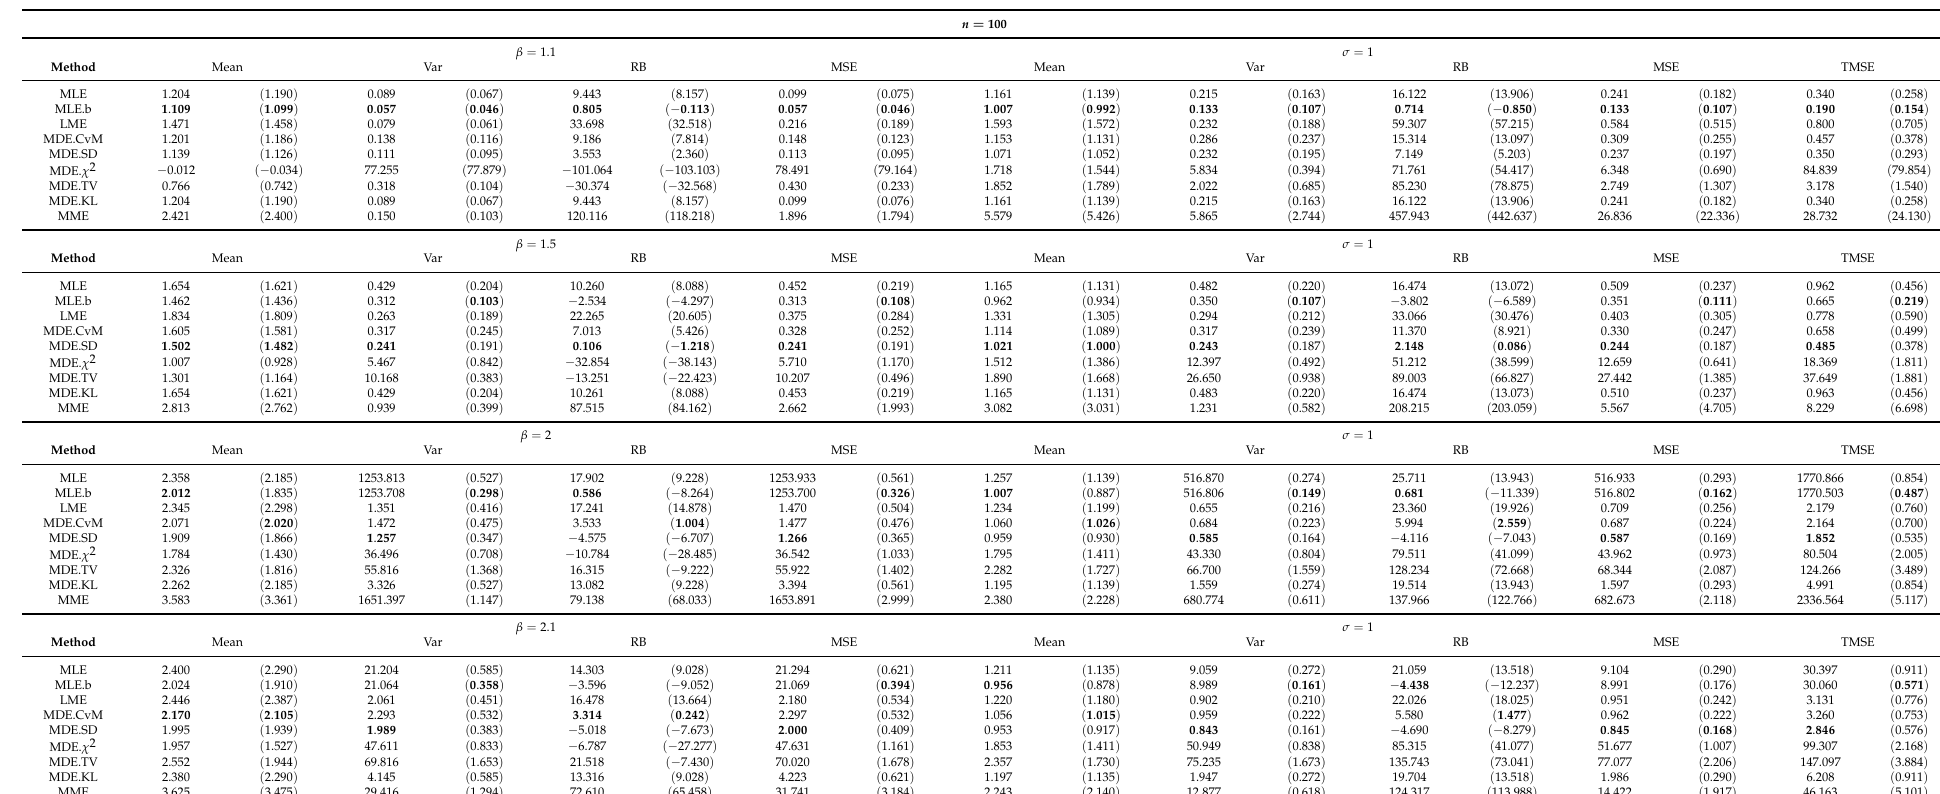
Table A1. Comparison of different estimation methods for different values of β ( σ = 1 and n =